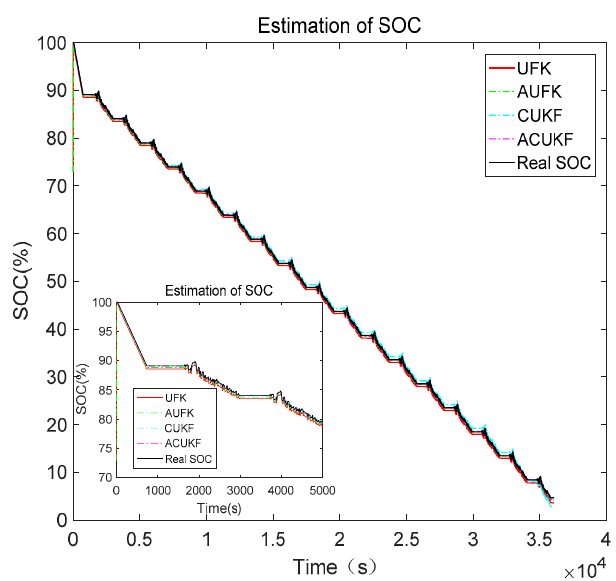
Figure 6. SOC estimate comparison using different methods under Gaussian noises.